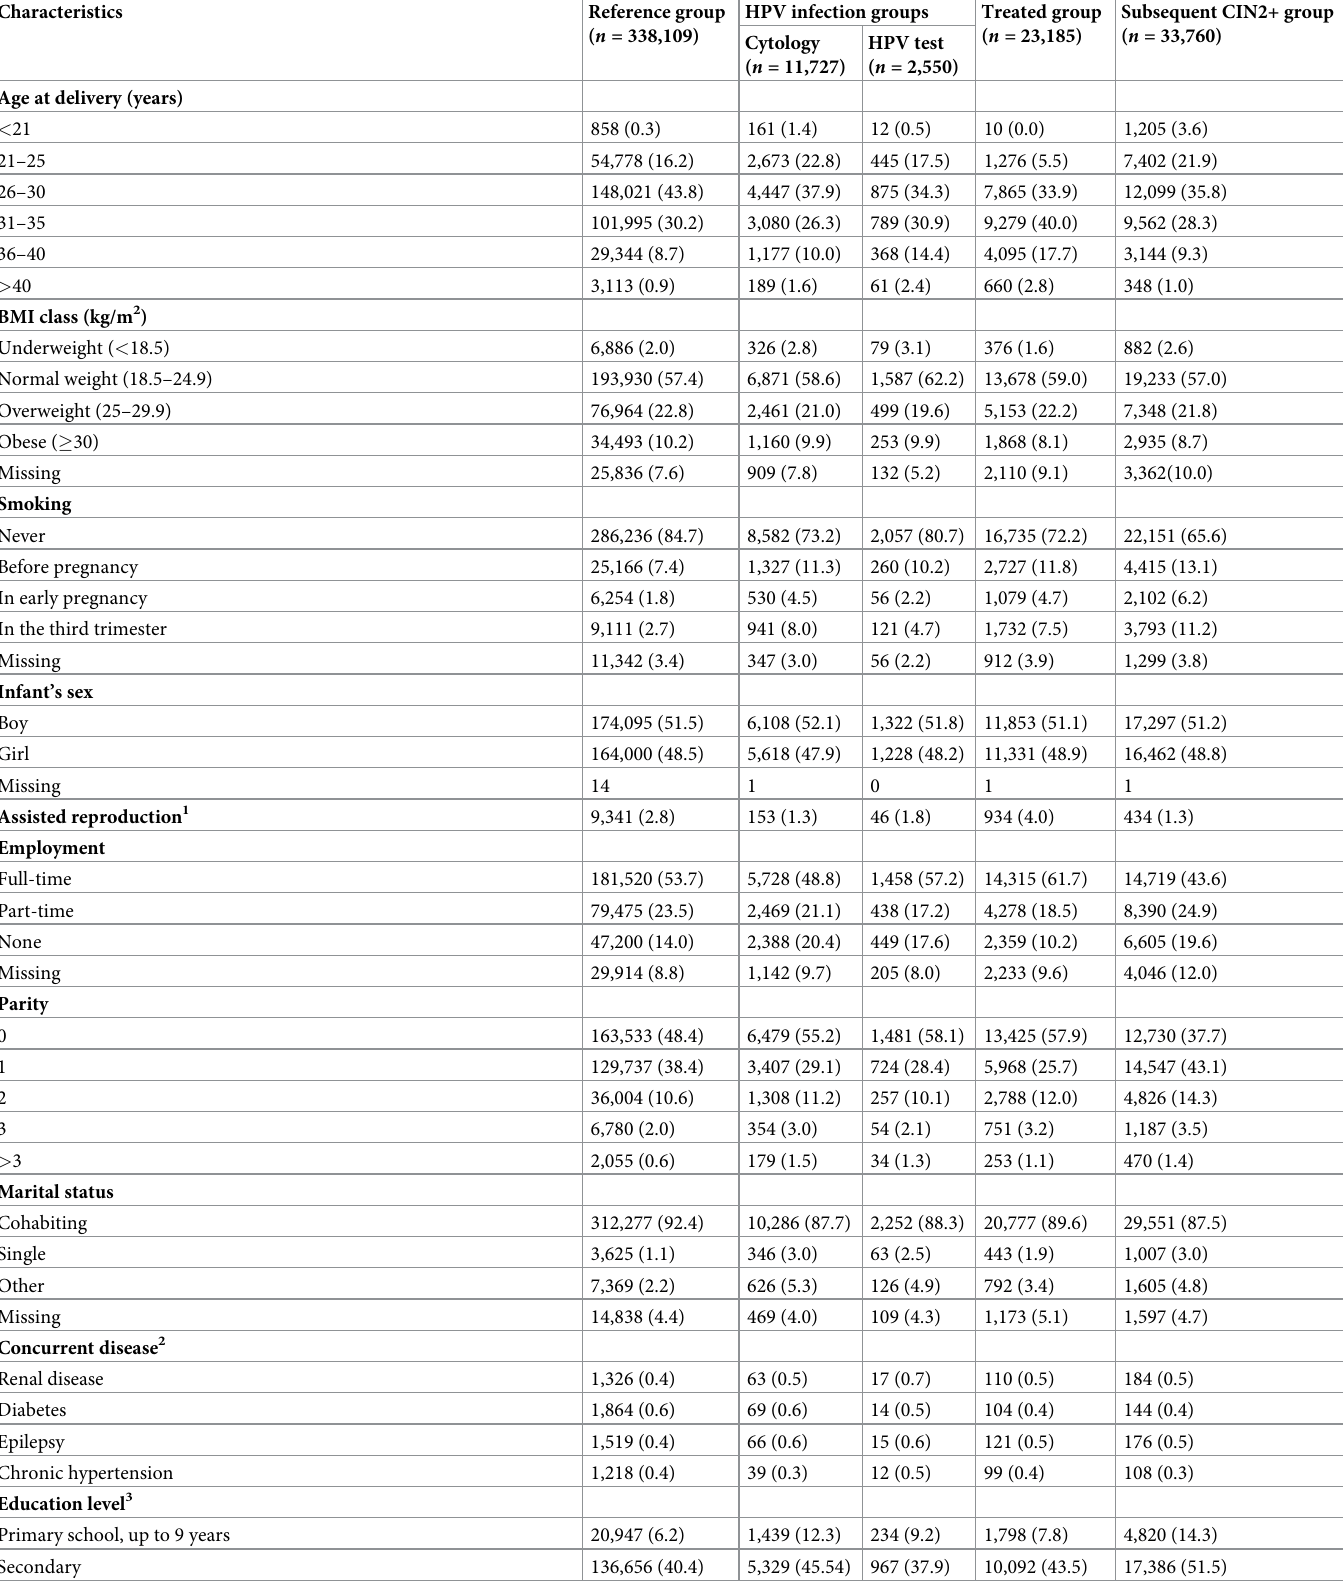
Table 1. Demographics and clinical characteristics in the study groups.